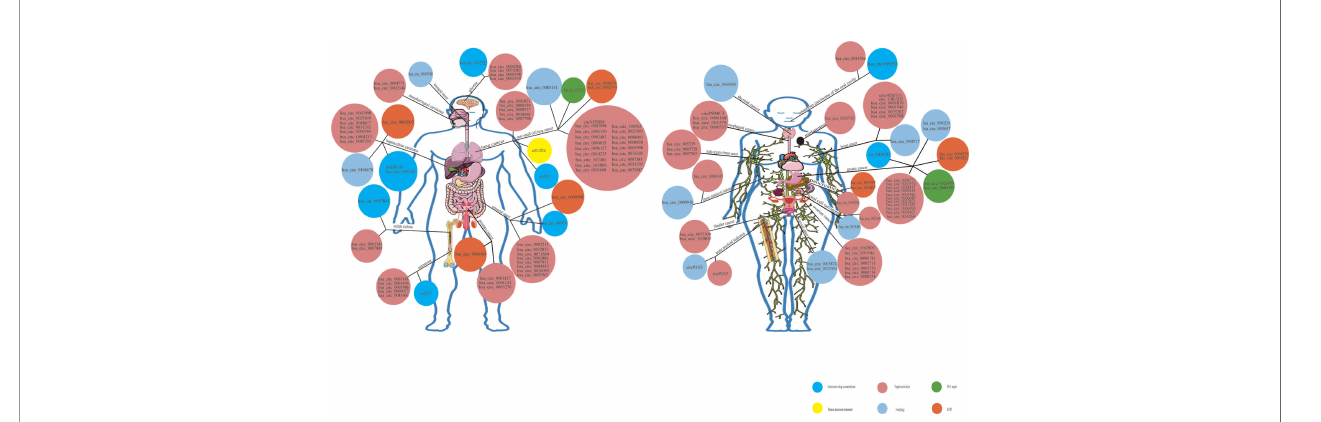
FIGURE 6 | Overview of functional circRNAs in various types of cancer. The map shows the circRNAs that have been con fi rmed to function in various types of cancer. As the mechanism of drug resistance is complex, only the main mechanism is listed in this map. Among the number other mechanisms, speci fi c mechanisms such as the regulation of metabolism, cell cycle, apoptosis, RNA binding proteins (RBPs), immune escape,etc, summed up as alterations in target gene copy number and the activation of bypass pathways or downstream